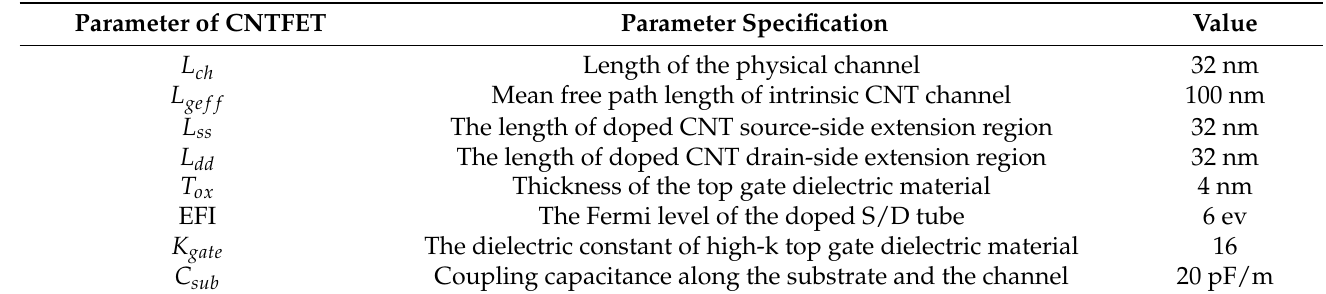
Table 5. Characteristic parameters and their values employed for CNTFET model.